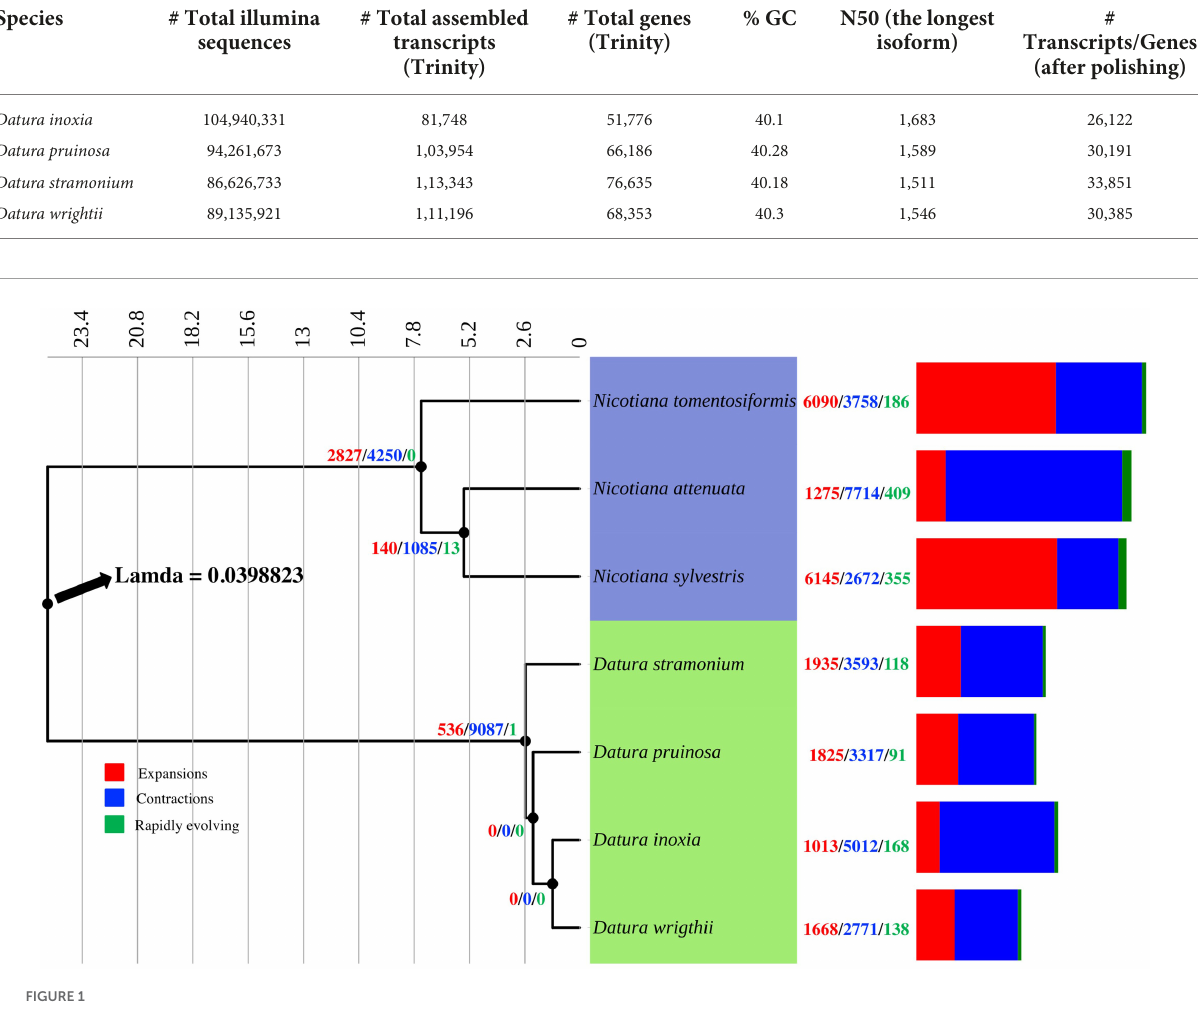
TABLE 1 RNA reads produced by the transcriptome assembly of four Datura species.